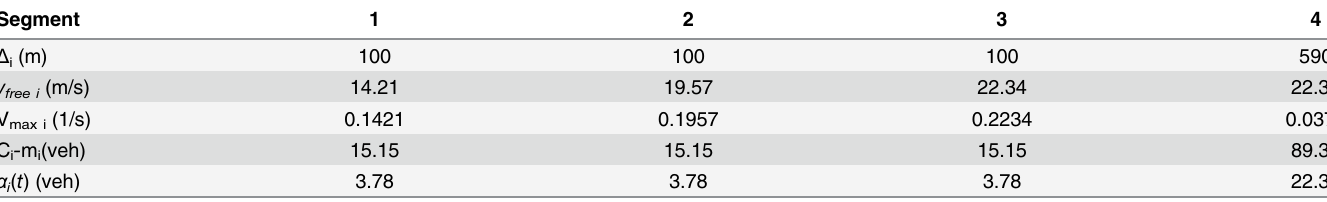
Table 2. Traffic parameters of VCPN (Persiaran Kuala